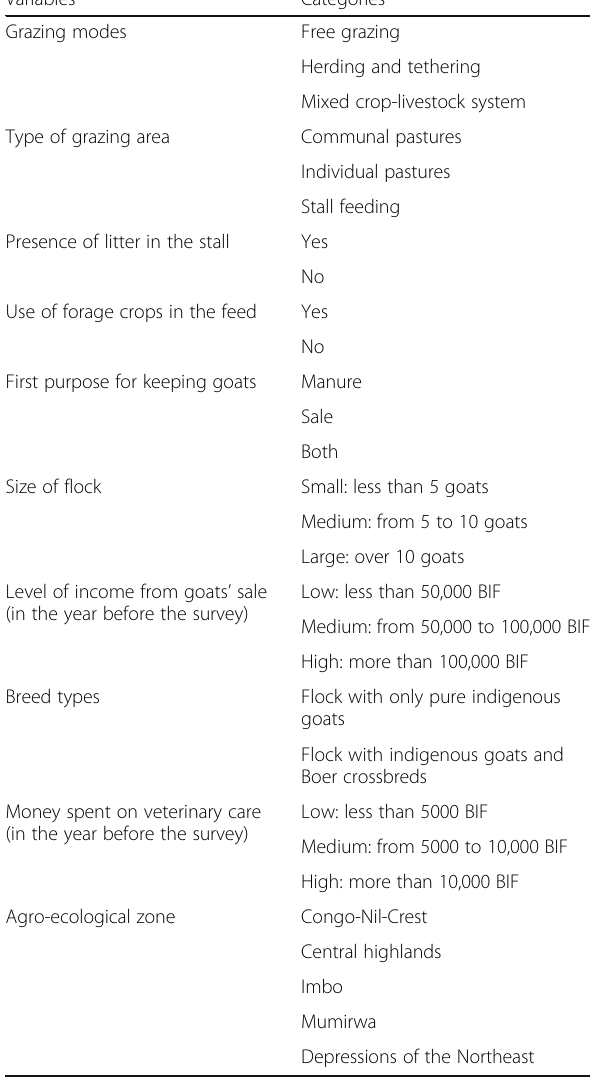
Table 1 Variables used in the multivariate analysis of the goats ’ production